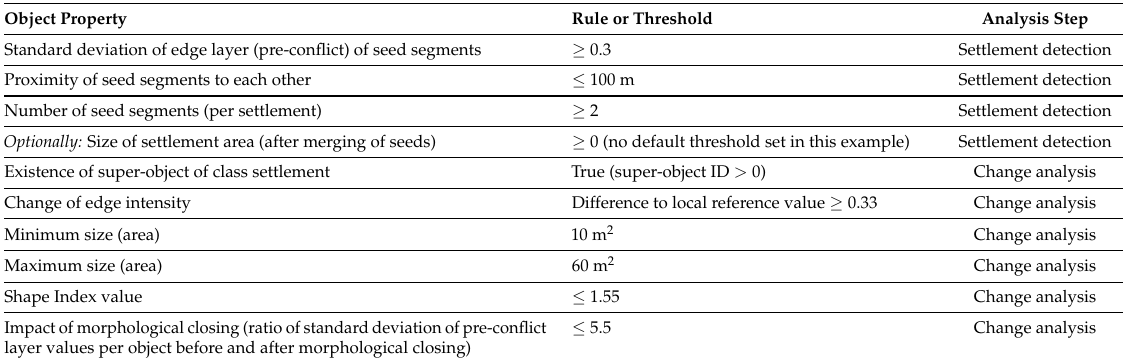
Table A1. List of properties used in the settlement detection and the subsequent detection of disappeared structures (within detected settlement areas) along with the corresponding rules and recommended